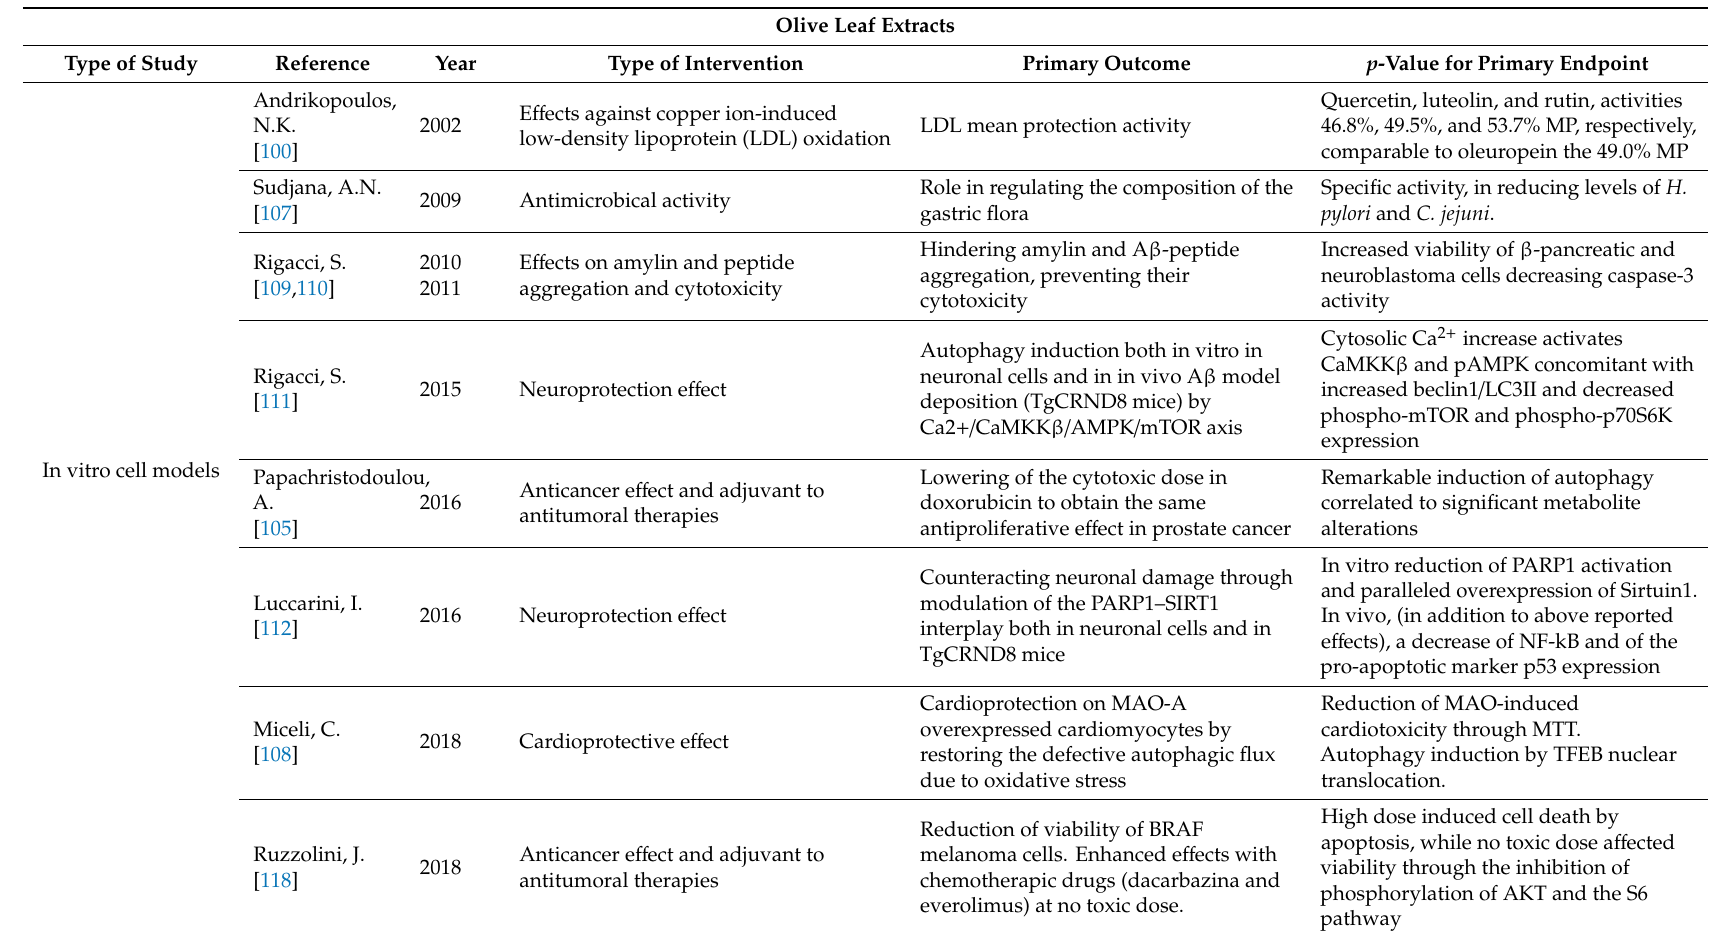
Table 4. Biological activity olive leaf extracts. Olive Leaf